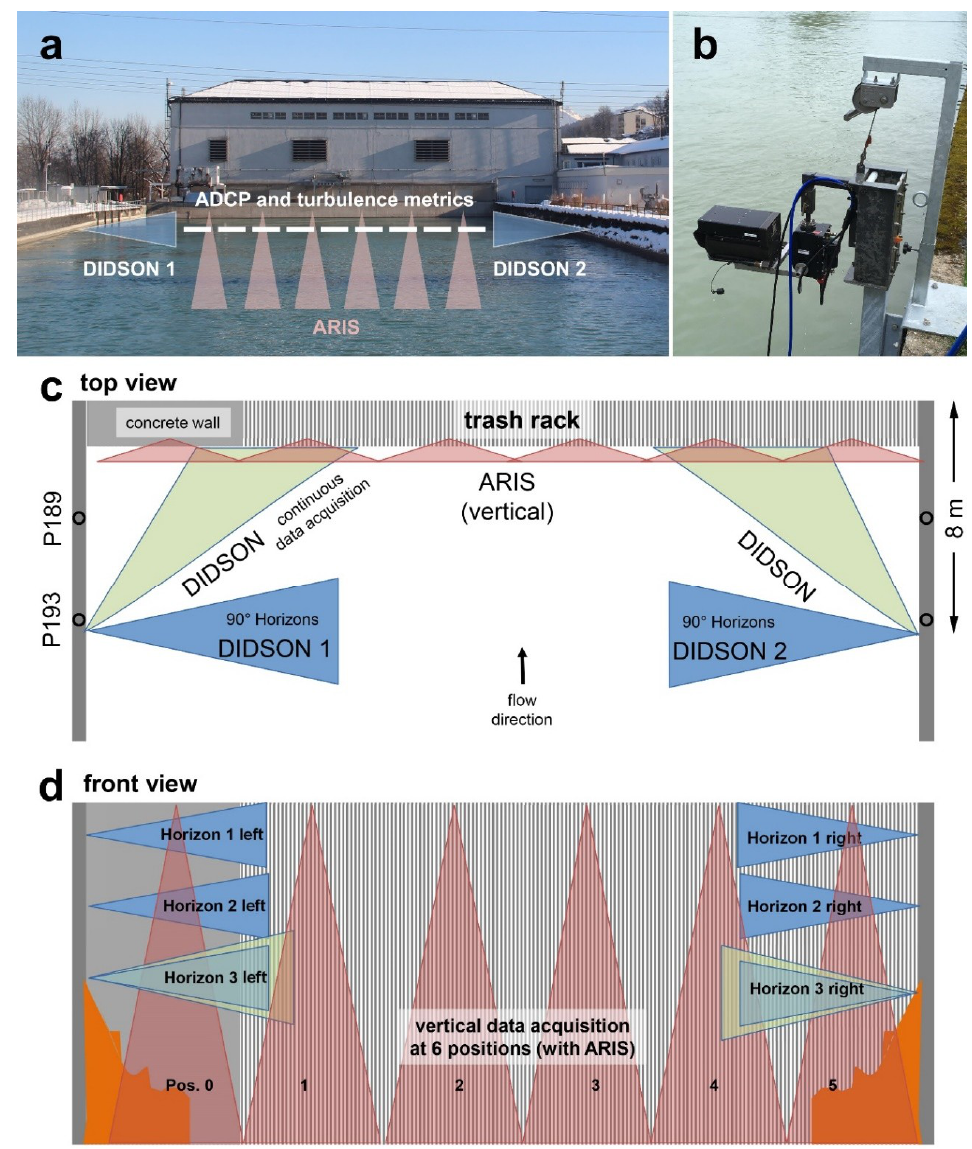
Figure 5. Hydroacoustic imaging setup with DIDSON and ARIS sonar systems in front of the trash rack: ( a ) Overview of site. ( b ) DIDSON. ( c ) Plan view (the DIDSON were installed close to profile 193, approximately 8 m from the uppermost edge of the inclined trash rack). ( d ) Front view (orange = sediment deposits in front of the trash rack). The vertical trash rack is inclined at an angle of 70°; i.e., when measured from the top of the trash rack, the bottom of the trash rack ends at the river bed 4 m in the upstream direction.